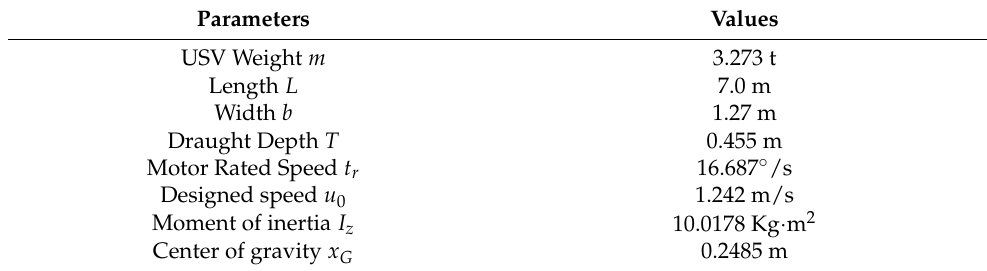
Table 1. Main parameters of the USV.